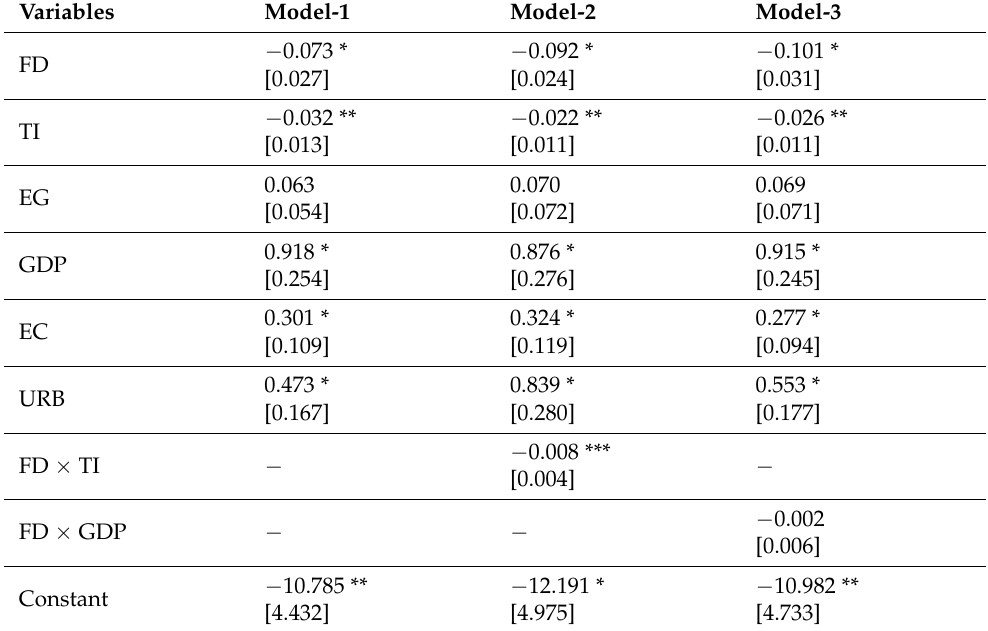
Table 7. Robustness check (AMG).